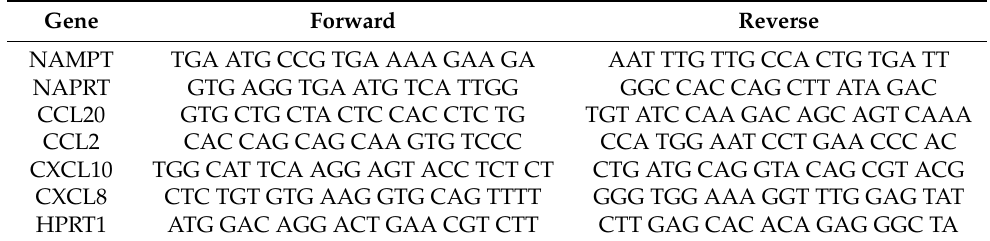
Table 1. Primers sequences used for real-time